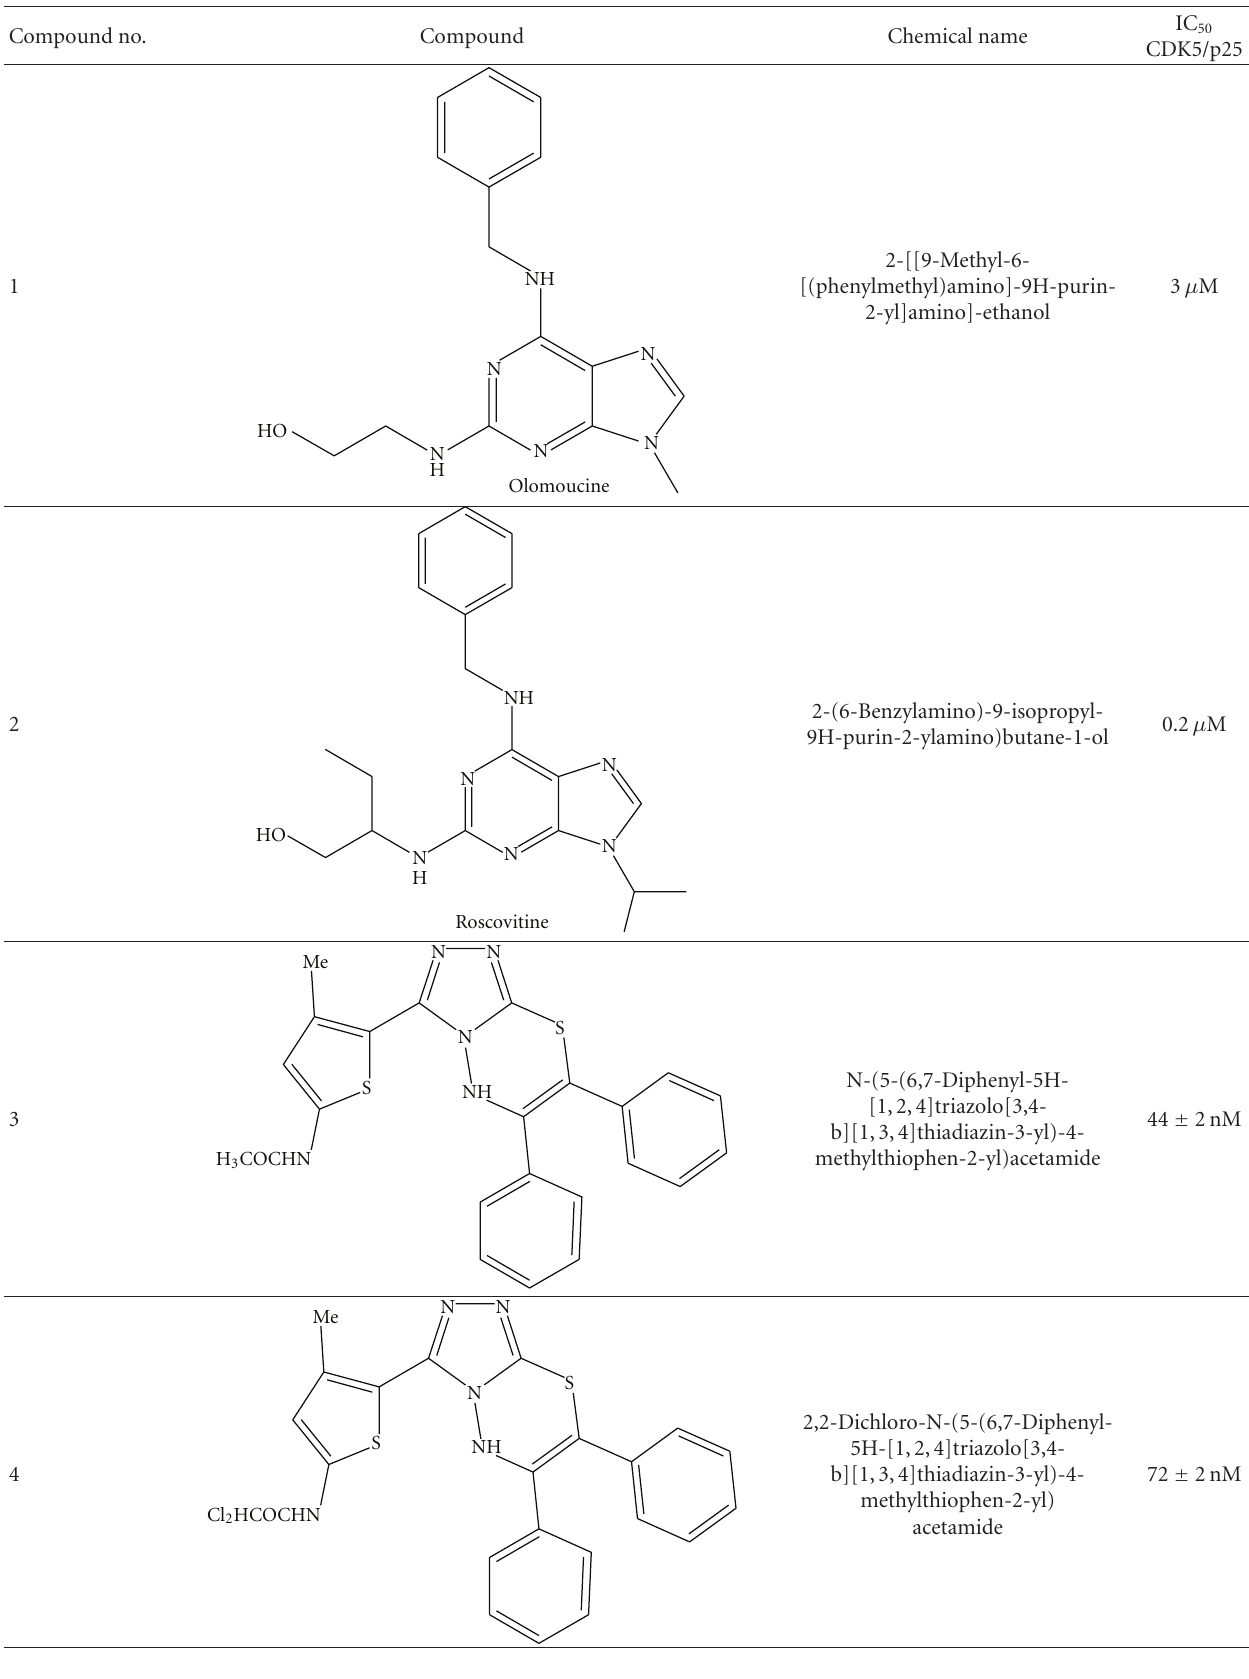
Table 1: IC 50 (nM/ μ M) of various CDK5